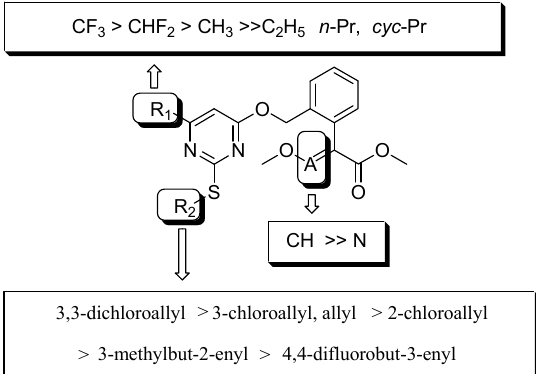
Figure 5. Structure activity relationships for the compounds 4a – 4u against adult T. cinnabarinus.